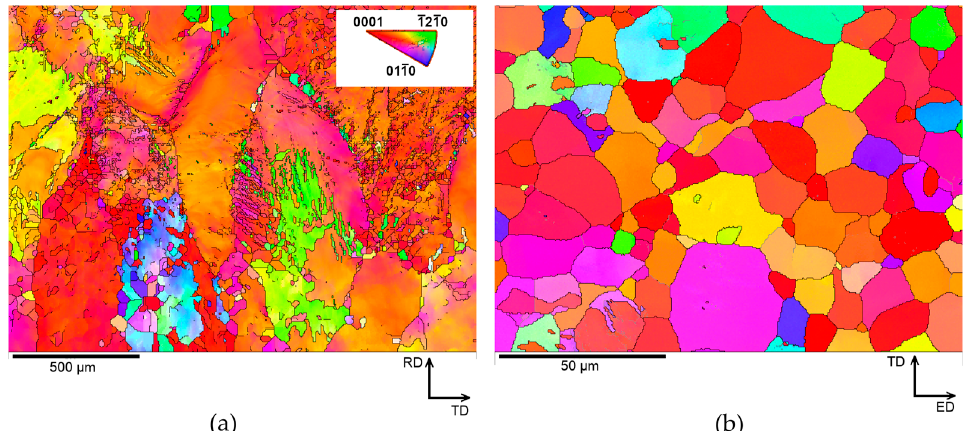
Figure 1. Light micrographs of initial as-cast material used ( a ) for rolling and ( b ) for extrusion.